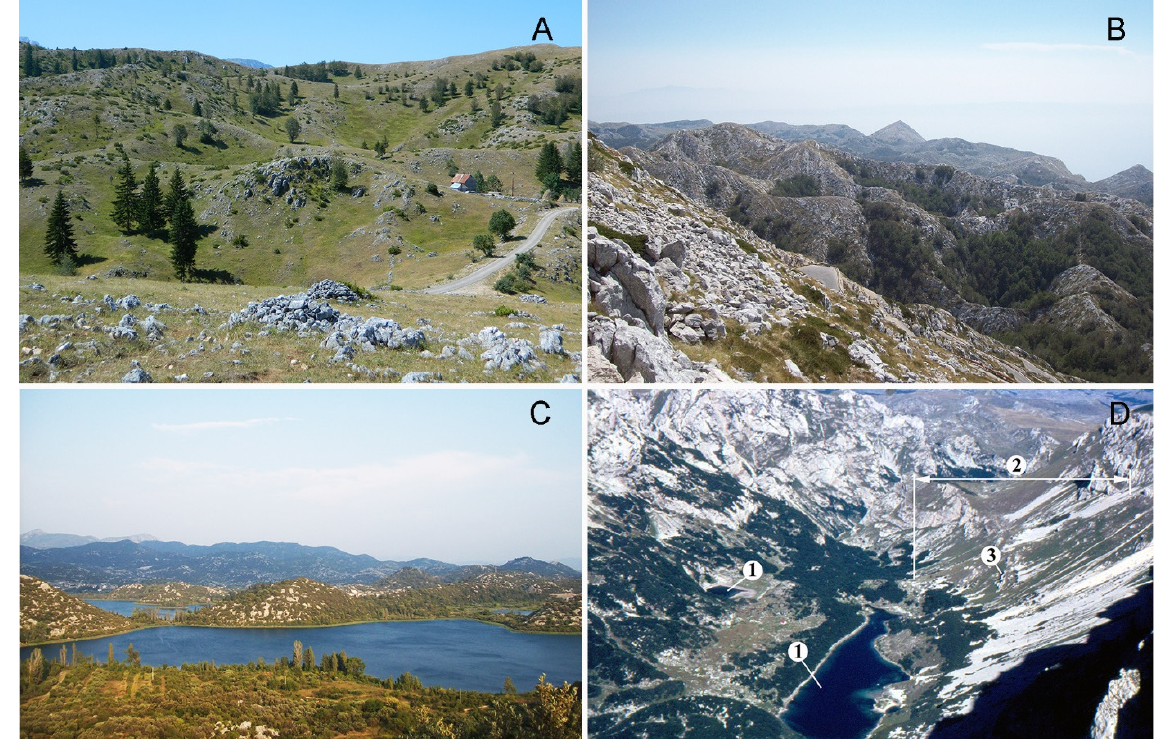
Figure 3. Azonal karsts according to morphology and effects (photograph taken by Márton Veress): ( A ) karst with dolines (Durmitor, Montenegro), ( B ) polygonal karst (Biokovo, Croatia), ( C ) karst with karst hills (Croatia), ( D ) glaciokarst (Durmitor). Legend: 1. rock basin, 2. debris slope, 3. margin of partial doline covered with debris.